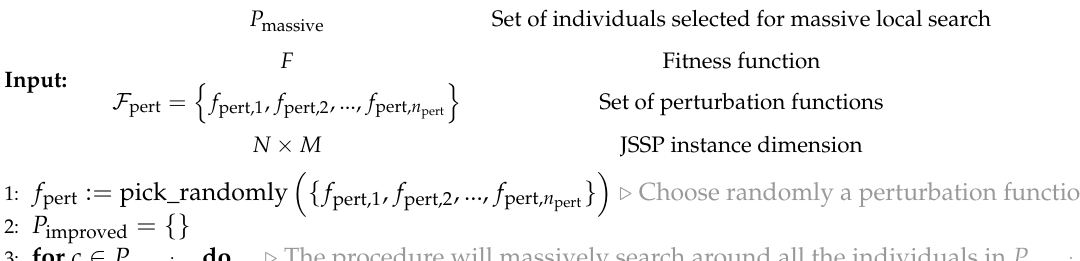
Algorithm 3 Proposed massive local search